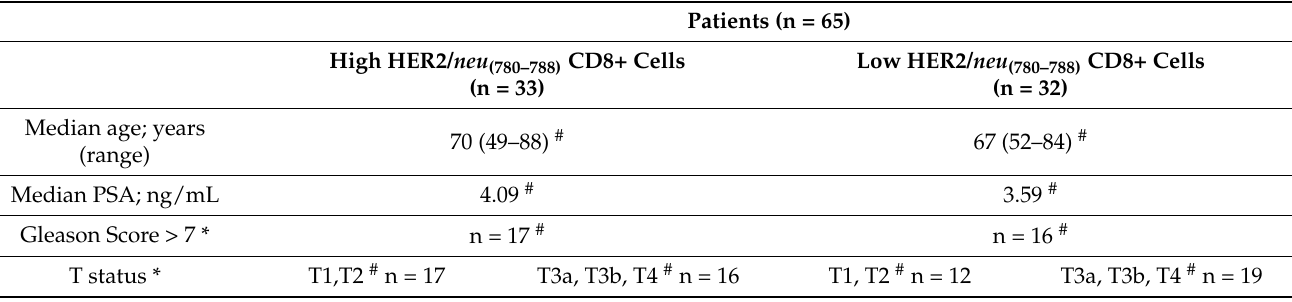
Figure 2. High densities of total HER-2/ neu (780–788) -specific CD8+ T lymphocytes are associated with improved progression-free survival (PFS) in prostate cancer (PCa) patients. The Kaplan–Meier survival curves indicate PFS for patients with high (above or equal to the median value; red line) vs. low (below the median value; black line) frequencies of the total HER-2/ neu (780–788) -specific CD8+ T lymphocytes. Table 1. Clinicopathological characteristics of the prostate cancer (PCa) patients enrolled in this study. The patients were separated in two groups based on the identified frequencies of HER-2/ neu (780–788) CD8+ cells (high vs. low).